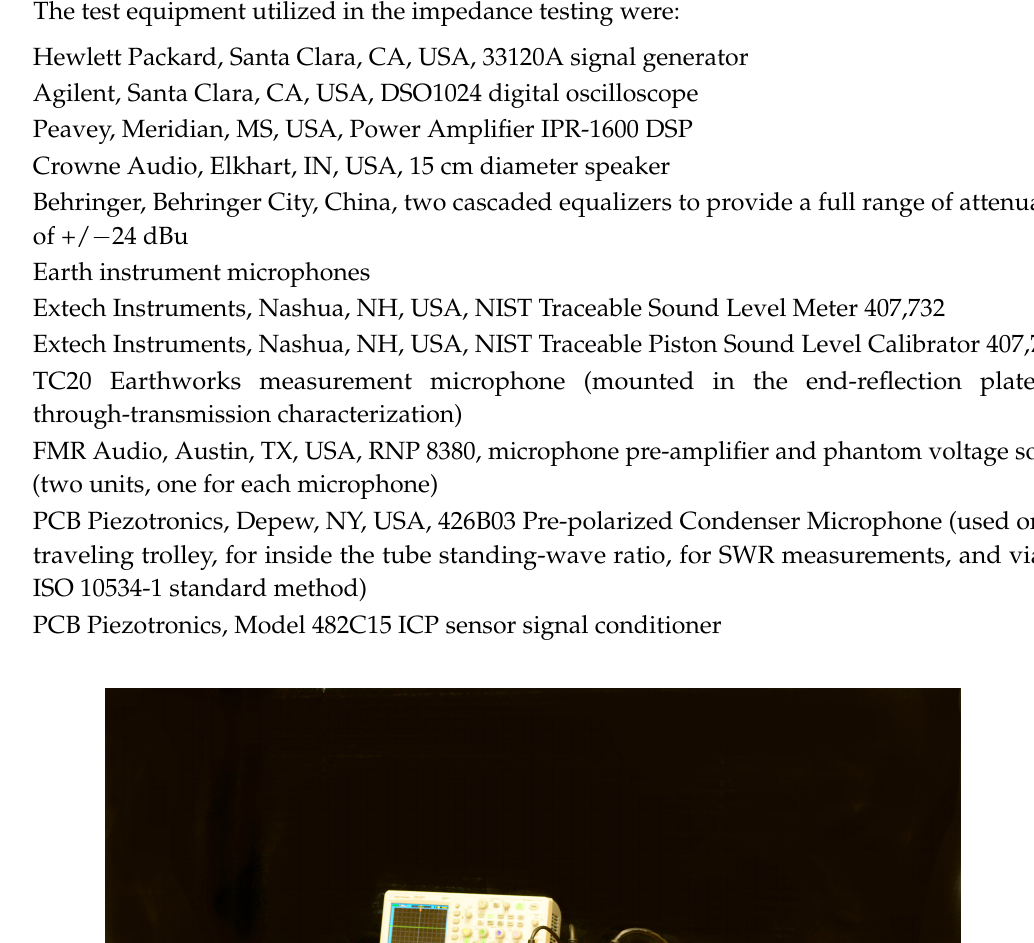
( c ) Figure 3. Picture showing the various instrumented end plates for the experimental test apparatus utilized in the study. Each of these end plates provided a different means to obtain the Iwase [12] microphone 3 measurements. The image ( a ) on the left shows a microphone embedded into the end reflection plate. In the middle image ( b ) is the sample holder as well as an instrumented movable piston-style reflection plate. The piston configuration allowed for easy adjustment of the reflection plate location. Seen on the far right in image ( c ) is a reflection plate with an NIST traceable A-weighted sound meter mounted in a pressure-tight sealed reflection plate. Option ( c ) provided the easiest method of the three, and provided the lowest-cost entry into acoustic testing. Each sample was cut to a 31.75 mm diameter disc with a water-jet cutting machine and then placed into the sample holder utilizing petroleum jelly to provide an enhanced seal around the perimeter. For the denser samples, an additional step of hand-sanding was required to allow for sample insertion without undo force. It must be stressed that this step of properly sizing the samples to ensure a very tight fit was critical to ensuring repeatable results with the high dynamic range required by the higher density materials tested in this study. For statistical analysis, it is helpful to have a single quality variable associated with each test candidate. In acoustics, it is common practice to form a single-valued comparison variable, where the spectral readings are reduced to a single value by computing an integral sum of A-weighted sound